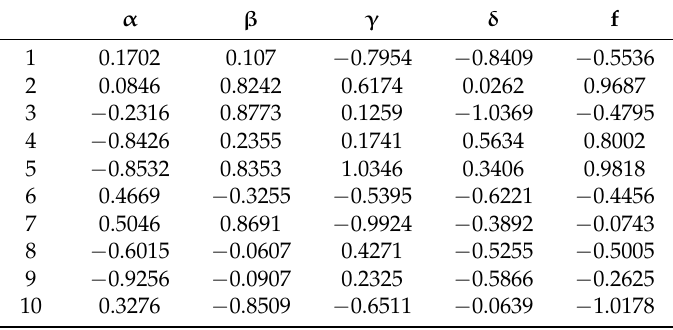
Table 6. The coefficient of the first hidden layer parameters and the input parameters’ quantitative